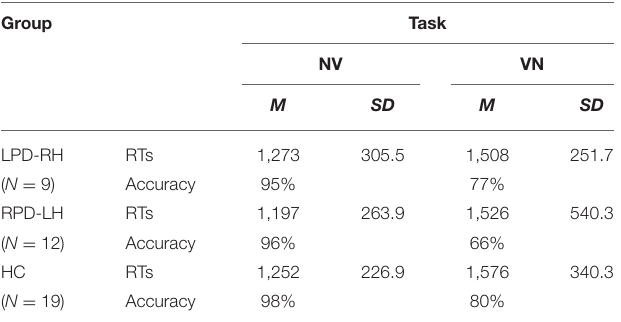
TABLE 3 | Mean (M) and Standard Deviation (SD) RTs (ms) and accuracy in generation (NV) and derivation (VN) tasks by groups.